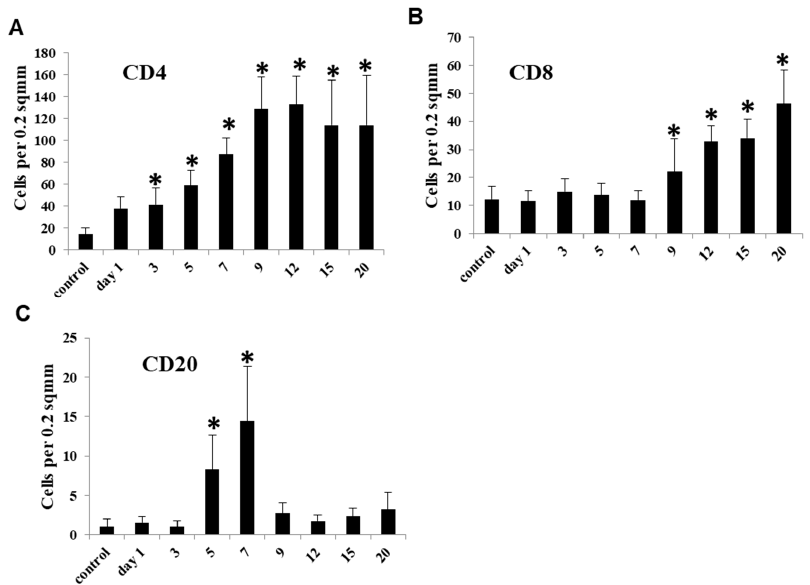
Figure 8. The number of lymphocytes reacting to CD4 ( A ), CD8 ( B ) and CD20 ( C ) in the control and CDDP-treated kidneys on days 1–20. Note that the kinetics of these lymphocytes to controls differs from each other. Dunnett’s test, *, significantly different from controls at p < 0.05.